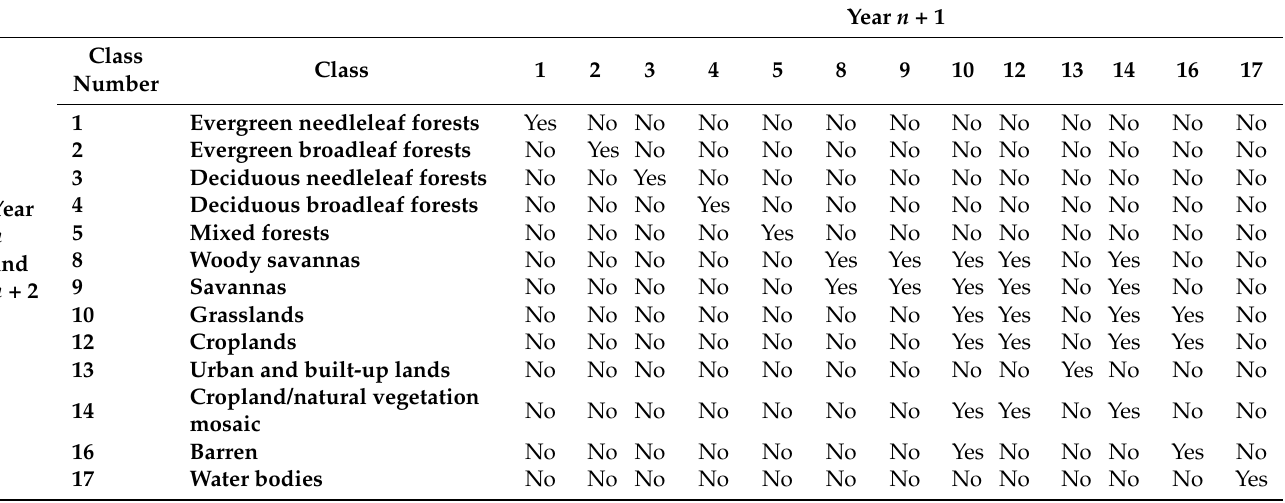
Table 4. Allowed and disallowed class transition for